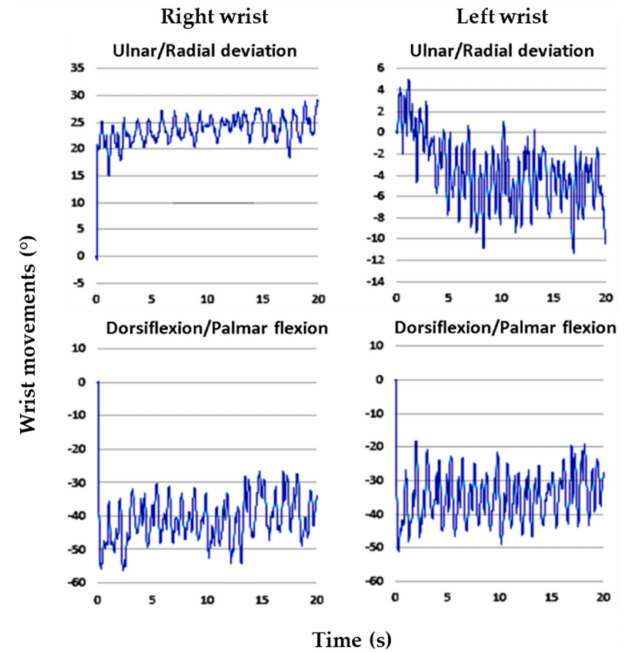
Figure 2. Alterations in the wrist posture during dough